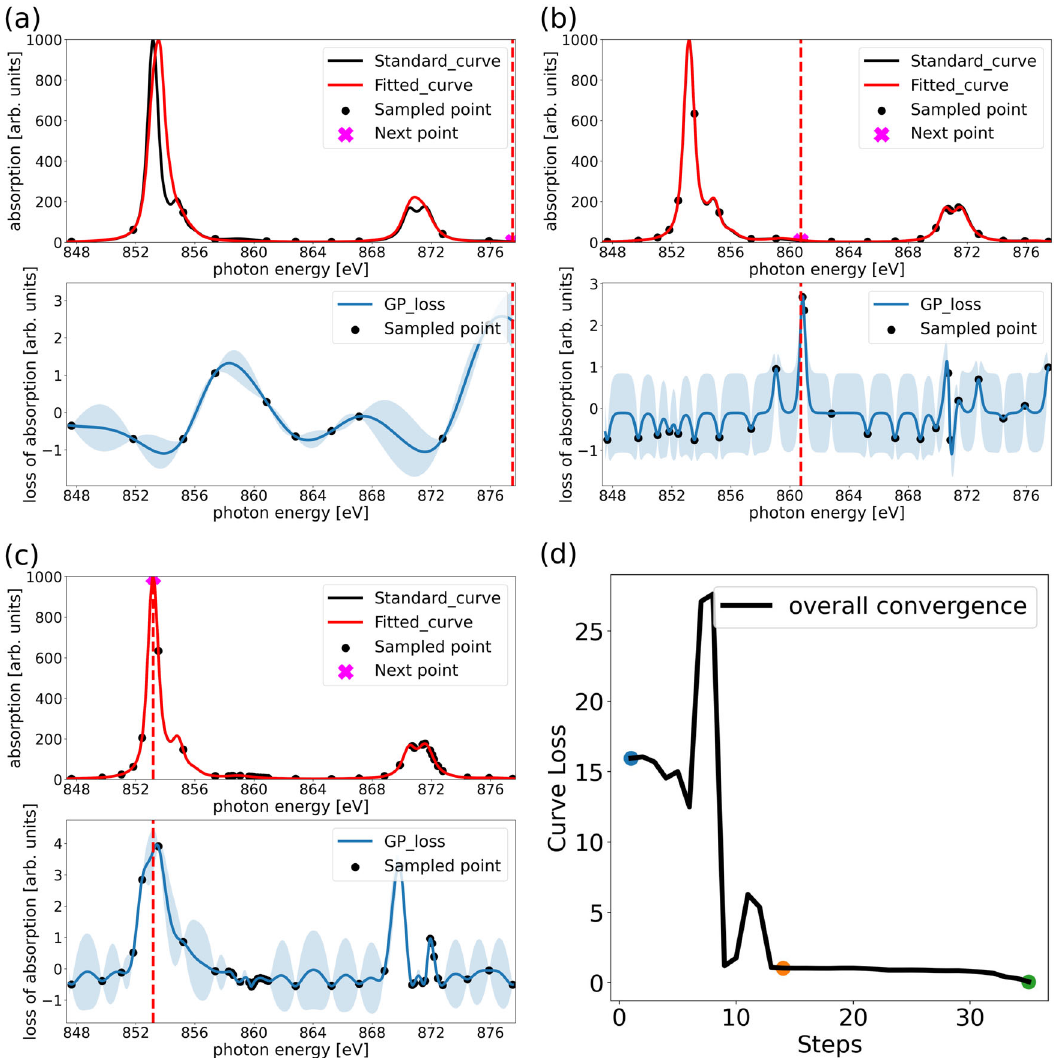
Fig. 2 The CTM model results. The fi tting results of the CTM model for differnet sampling points: a 10 sampling points (Step 1); b 23 sampling points (Step 14); c Final fi tting results using 44 sampling points (Step 35); d CTM XAS curve convergence, with the colored dots denote in order the results of Fig. 2a to c. The parameter comparison for listed steps is shown in Supplementary Table 6.